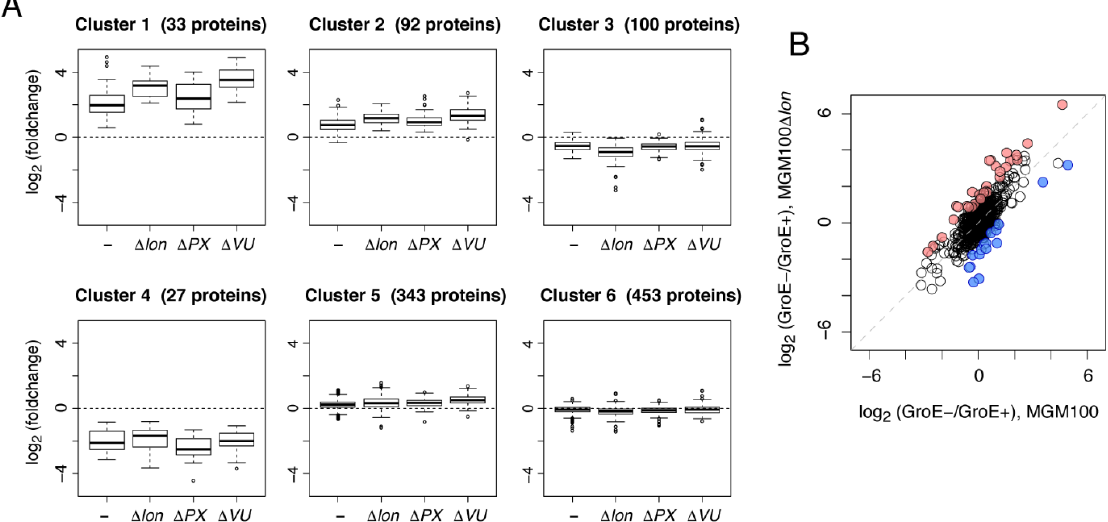
Figure 3. Clustering analysis to investigate the proteome perturbations induced by the protease deletions. ( A ) Distribution of the fold changes of the MGM100 and MGM100-derived protease- deletion strains in each cluster. Fold changes were defined as the protein abundance ratios under GroE-normal and GroE-depleted conditions in each strain. The box portions and the central bands are described according to the 25th percentile and the median, respectively. ( B ) Fold change comparison between MGM100 and MGM100 Δ lon . Red dots indicate the proteins specifically up- regulated by the Lon deletion, and blue dots indicate the proteins specifically down-regulated by the Lon deletion. Table 3. Enrichment analysis with the KEGG BRITE hierarchy for each cluster.